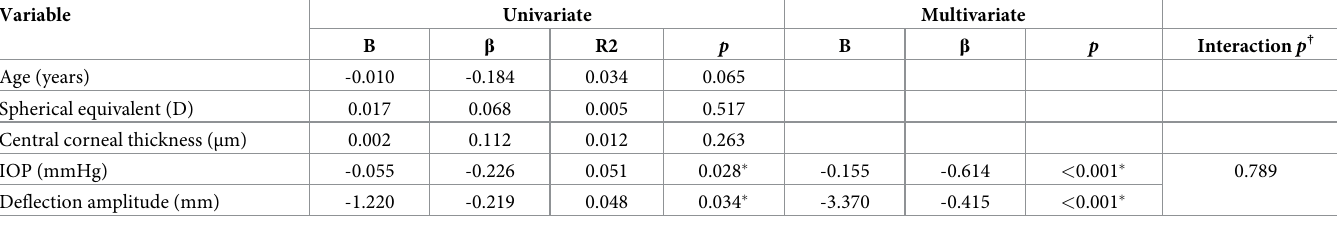
Table 2. Results of linear mixed effects model investigating the effect of deflection amplitude on visual field progression rate.